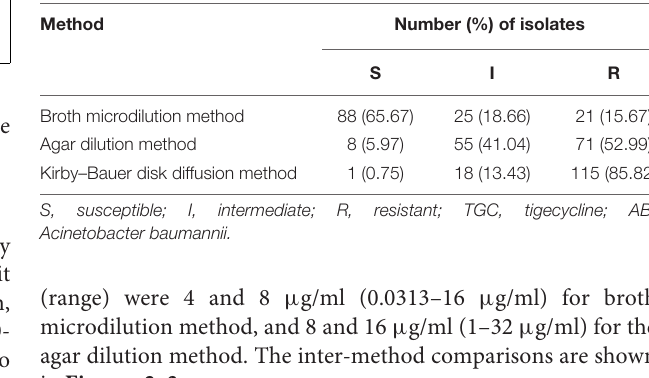
TABLE 4 | Inter-method comparisons of TGC against